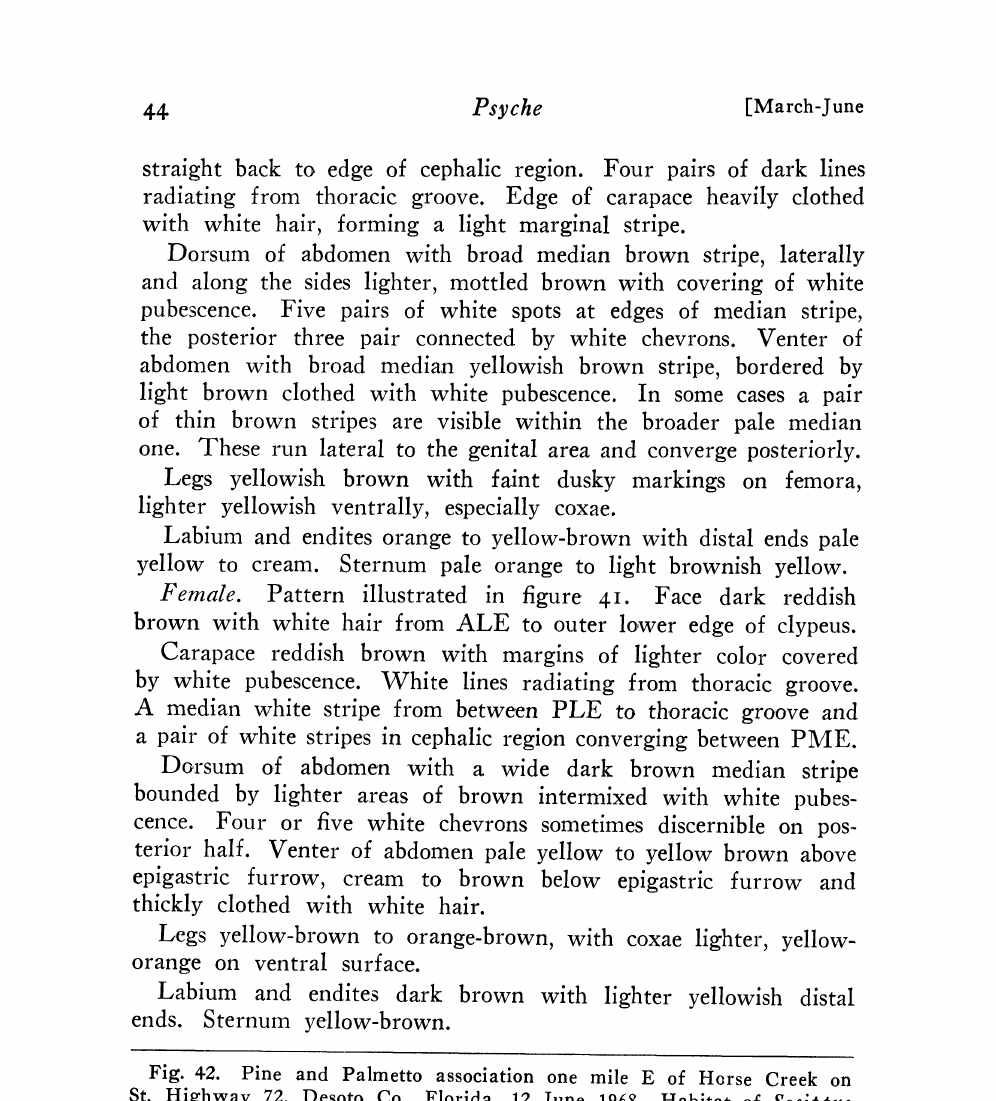
Fig. 42. Pine and Palmetto association one mile E of Horse Creek on St. Highway 72, Desoto Co., Florida, 12 June 1968. Habitat of Sosippus floridanus Simon. Fig. 43. Mesic woodland on NW shore of Lake Lochloosa, Alachua Co., Florida, 20 June 1968. Type locality of ,%sippus janus sp. n. Fig. 44. Very dry clearing with Opuntia as the dominant vegetation, 6 mi. S of Lake Placid, Highlands Co., Florida, 12 June 1968. Type